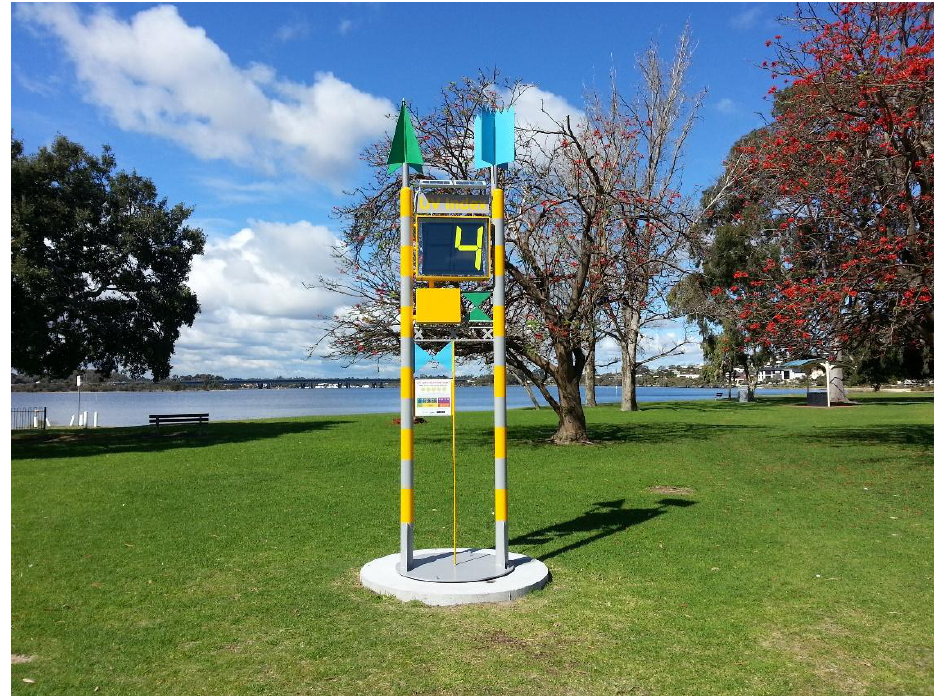
Figure 4. A UV meter displaying the live UV Index at Deep Water Point Reserve in Western Australia (Image courtesy of Cancer Council Western Australia).